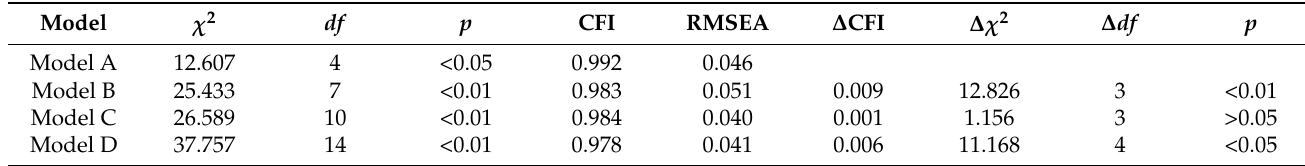
Table 2. Analysis of invariance across